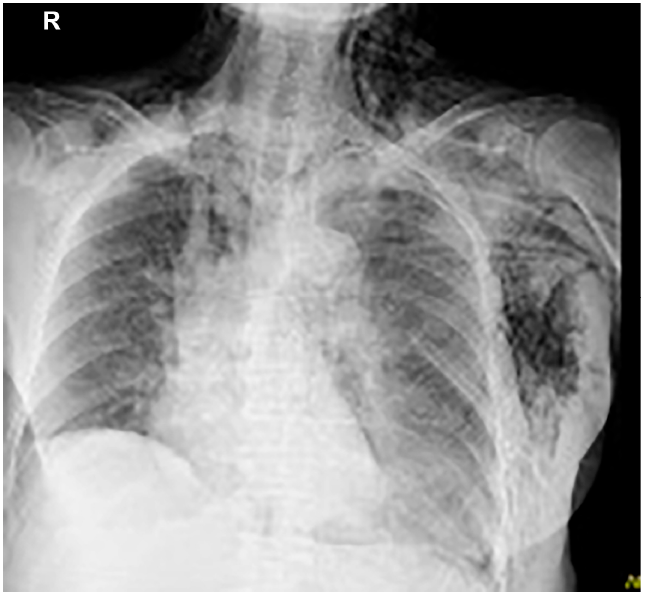
Figure 2. Mediastinal and subcutaneous emphysema was observed in the anterior mediastinum and on the left sides of the chest, respectively.